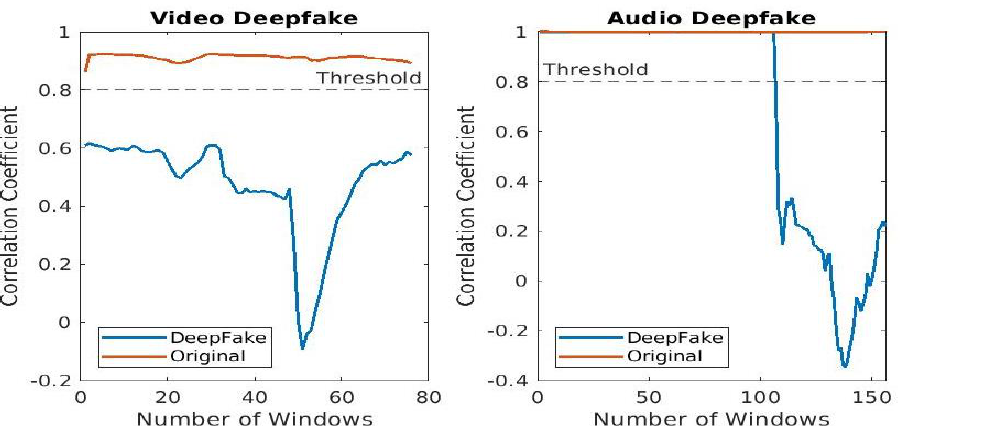
Figure 7. Deepfake detection in audio and video recordings by ENF signal comparison with RFA